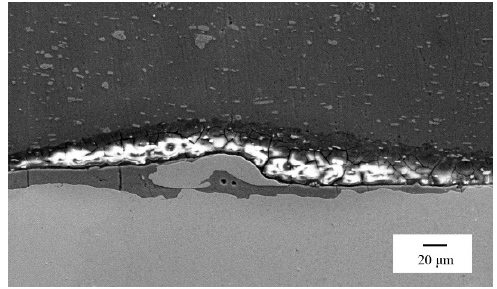
Figure 11. Interface morphologies of center area with 12 kJ energy input.